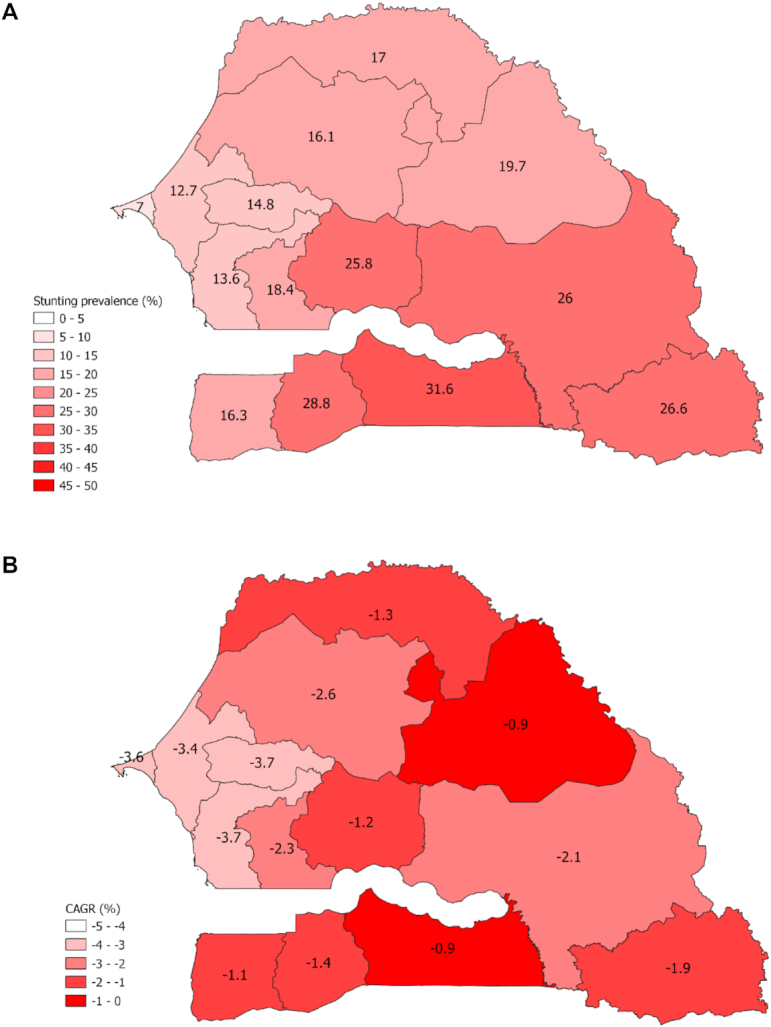
Subnational stunting estimates for children <5 y old in Senegal in 1992/93 (A). CAGR by region, 1992/93–2017 (B). CAGR, compound annual growth rate.